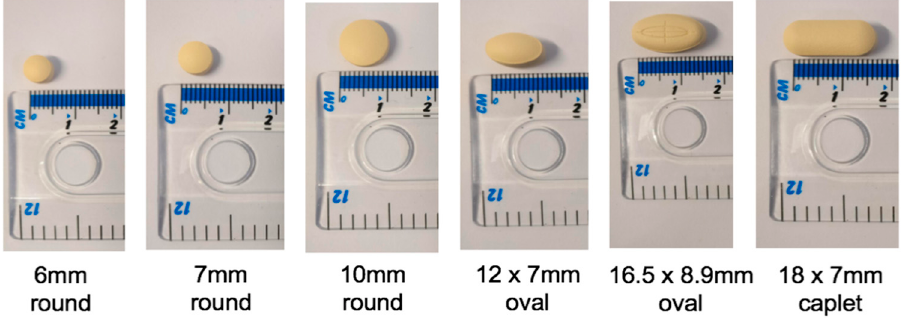
Figure 1. Placebo tablets used in interviews.